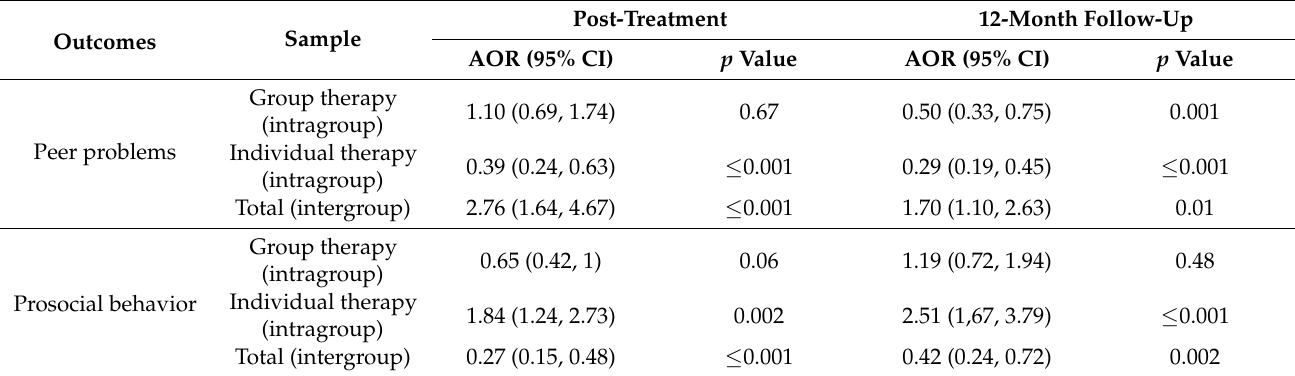
AOR = Adjusted Odds Ratio. CI = Confidence Interval. Higher scores denote greater symptomatology, except for Prosocial behavior (higher scores indicate more prosocial behaviors). Each analysis was adjusted for baseline assessment, children’s age and sex, and clustering within